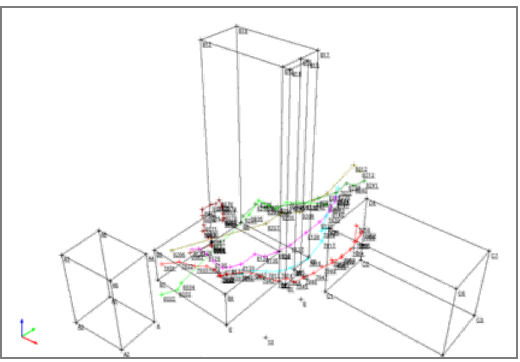
Figure 14. Paths of particle around the high